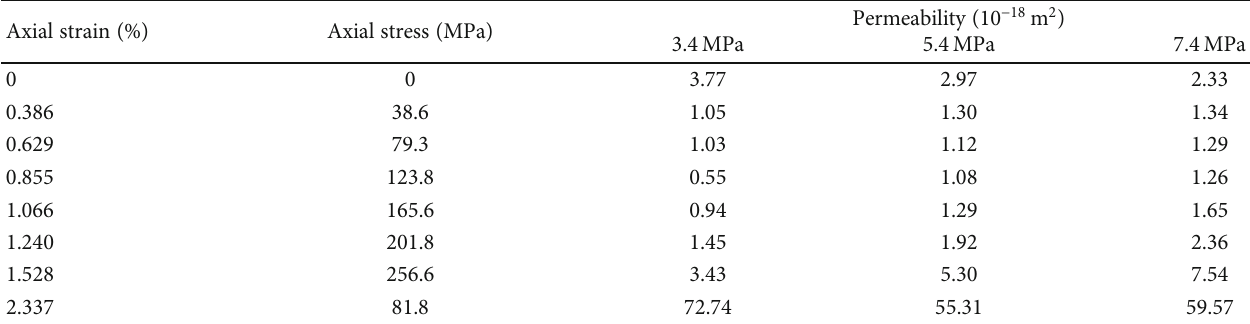
Table 1: Permeability test results for specimen BSS-1 for three di ff erent initial pressure di ff erences.